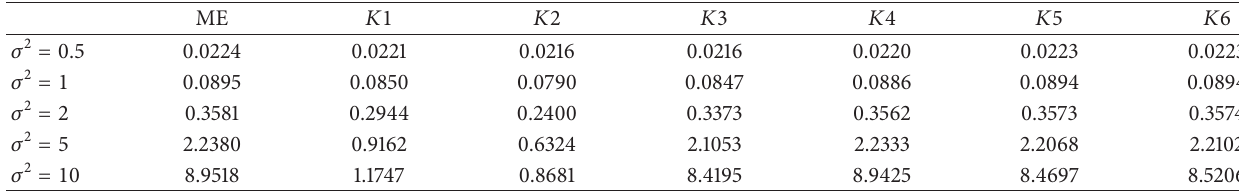
Table 15: Estimated MSE with 𝑛 = 50 , 𝑝 = 6 , and 𝛾 = 0.95 .